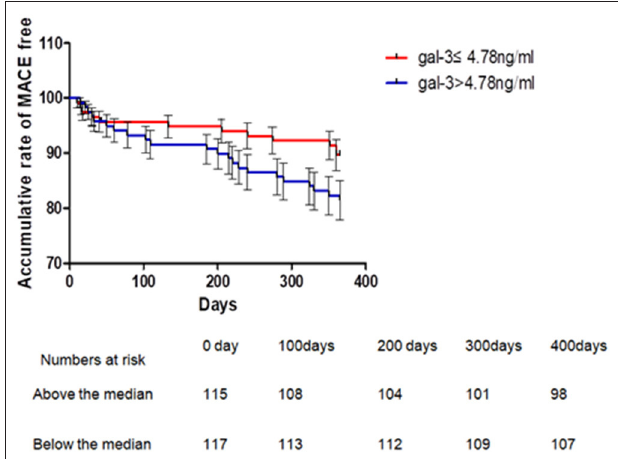
FIGURE 3 | Kaplan-Meier’s curves for 1 year MACE according to levels above or below median of serum Gal-3 in patients with ACS. One-year MACE events were significantly higher in Gal-3 > 4.78ng/ml group than that in the Gal-3 = 4.78ng/ml group, P = 0.036 (Breslow). ACS, acute coronary